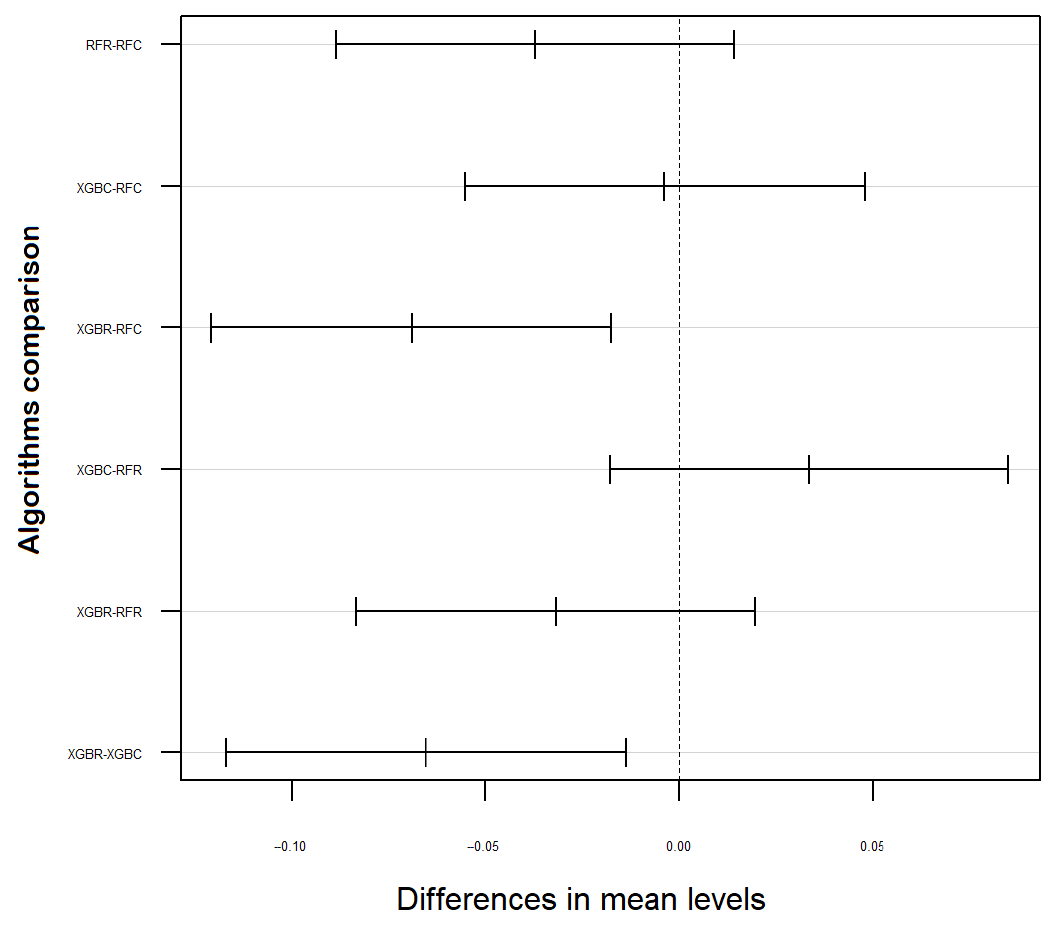
Figure 10. Tukey’s test over classifiers and regressors.